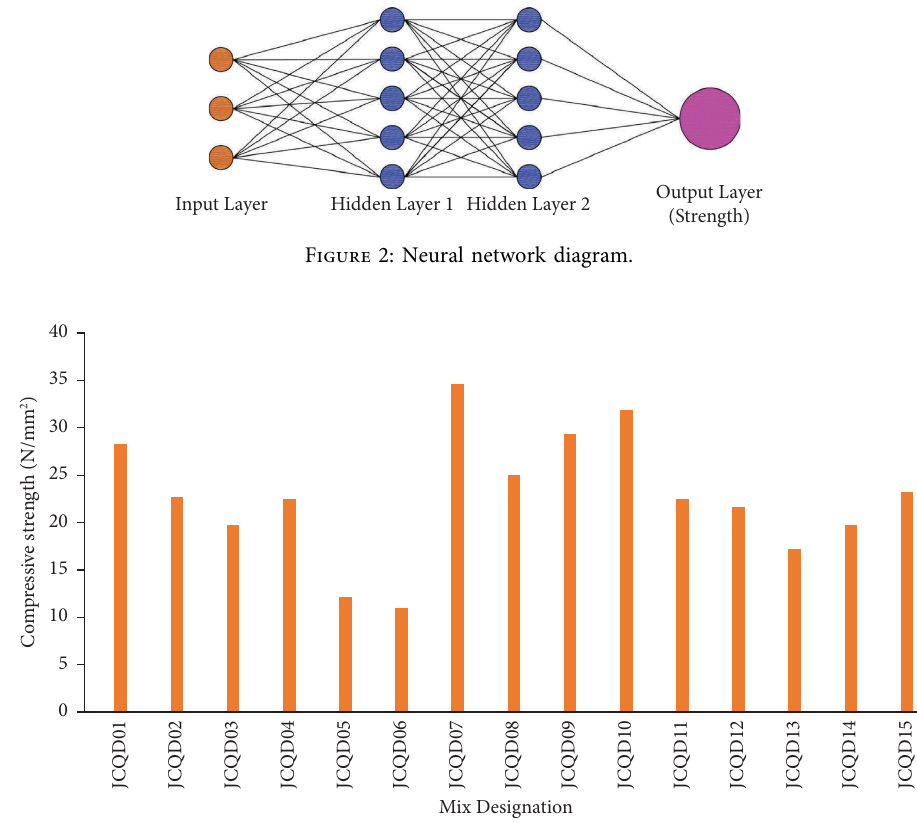
Figure 3: Concrete compressive strength with jute fbres, coconut fbres, and quarry dust.